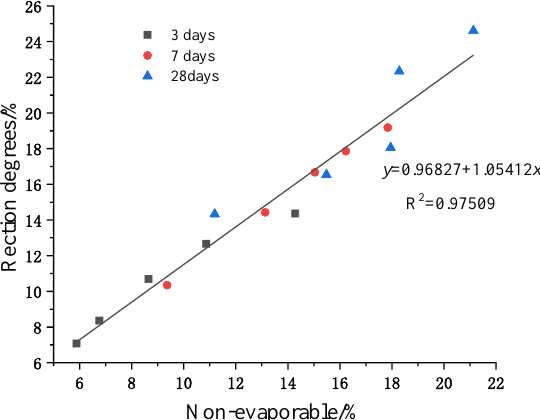
Figure 3. The correlation between the non-evaporable water content and reaction